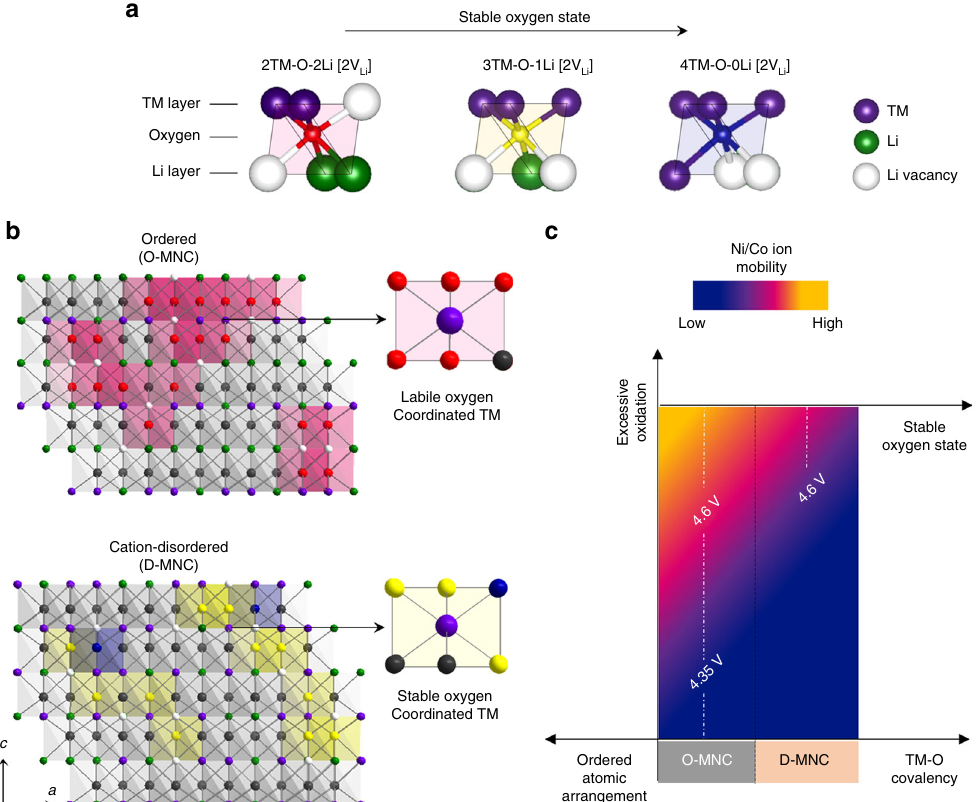
Fig. 6 Factors to consider in interpreting the structural stability of high capacity cathode material. a Three de-lithiated oxygen-centred octahedron (M 4 O) of Li-excess material. Each oxygen anions coordinated by four cations and two lithium vacancies (V Li ) with different portion of Li + and transition-metal in TM and Li layer. 2TM-O-2Li [2V Li ], 3TM-O-1Li [2V Li ] and 4TM-O-0Li [2V Li ] octahedron represent the base structure of de-lithiated Li 2 TMO 3 , LiTMO 2 and cation-disordered-LiTMO 2, and the degree of stability on centred oxygen represented as different color (Red is highly labile). b Oxygen-centred macroscopic structure model of de-lithiated state OH-MNC and D-MNC along [100] mono . c Schematic of structure stability according to the material characteristics and electrochemical